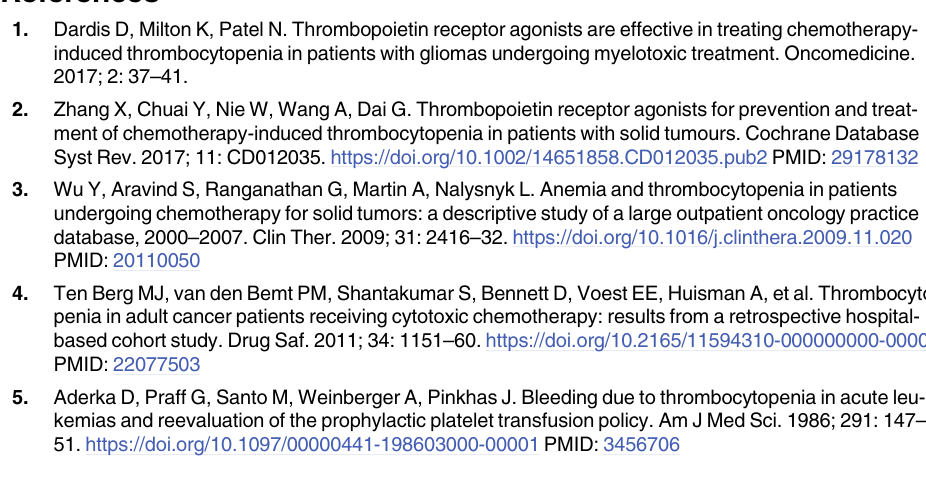
S9 Table. Sensitivity analyses including studies with thrombopoietic agent/comparator pairs only. S1 Results. Study characteristics and designs, thrombopoietic agent doses, and baseline demographics of studies that met the eligibility criteria for